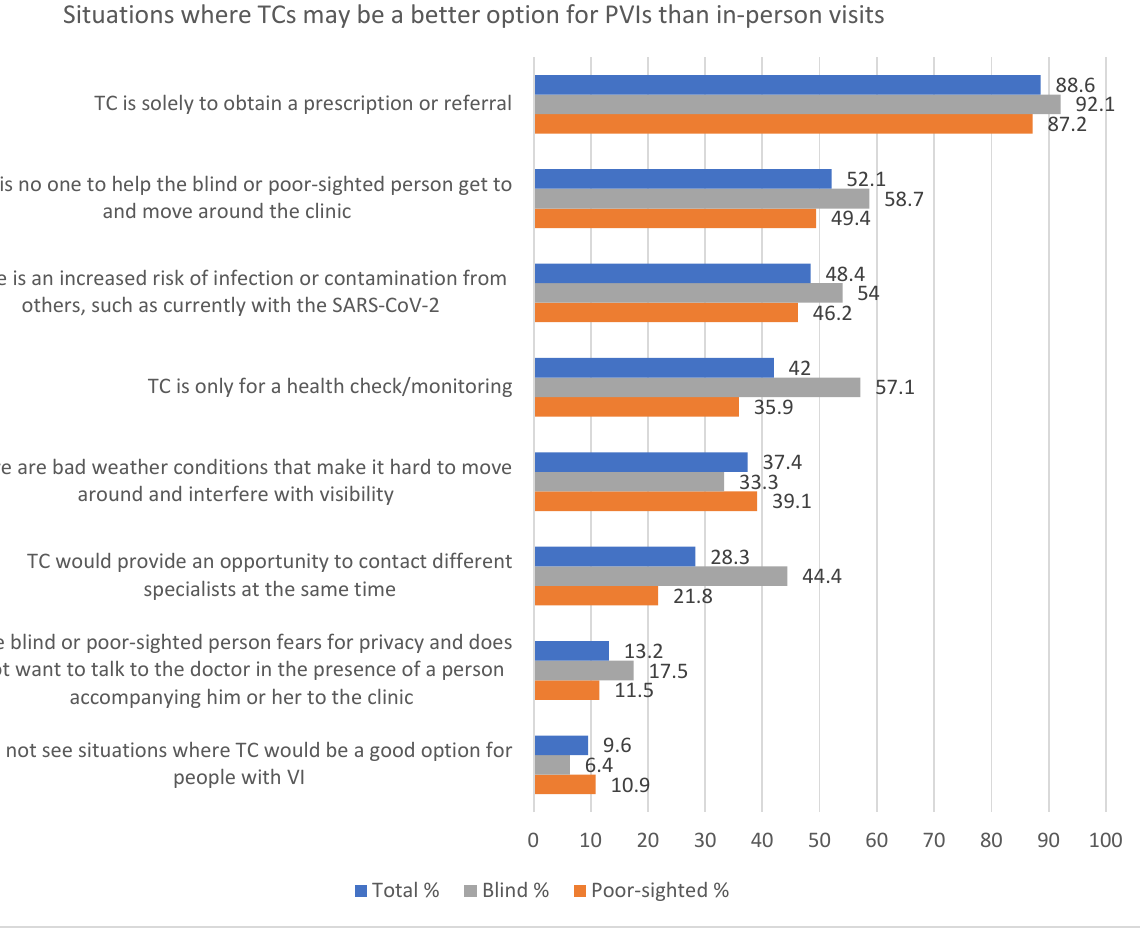
Figure 1. Reasons for using TCs by PVIs in percentages.